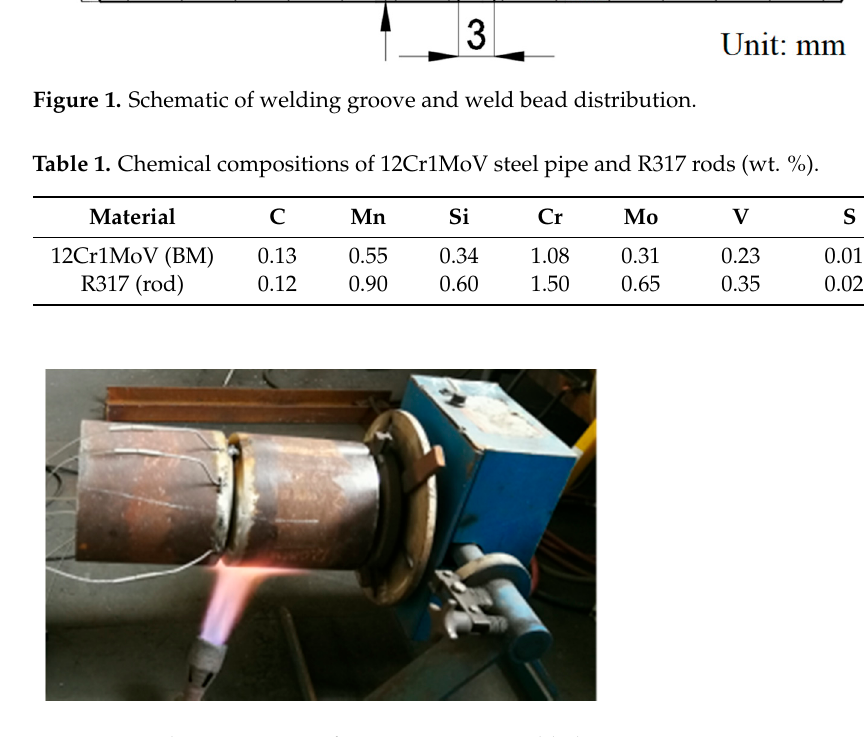
Figure 3. Schematic of temperature and residual stress measurement points. 2.3. Post-Weld Heat Treatment Process In order to investigate the distribution of welding residual stresses in the case of dif- ferent post-weld heat treatment, thermal cycle curve shown in Figure 4 was used, i.e., DHT and tempering treatment were carried out successively. DHT was conducted at 350 °C for 2 h, while tempering was conducted based on the industry recommended 730 °C for 1.5 h [26].